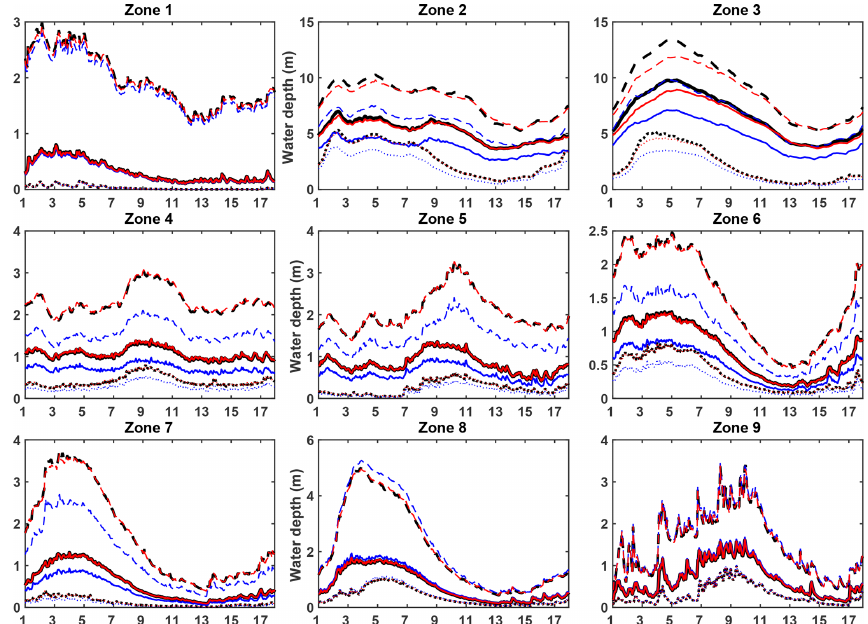
Figure 10. Water depth assimilation results for the PE3 experiment: daily evolution of the ensemble-averaged analysis water depth (red lines) compared to the true water depths (black lines) and the openloop water depths (blue line). For each zone (one per subplot), the median (full line), the first decile (dotted line) and the ninth decile (dashed line) of water depth ensembles over all grid cells in the zone are